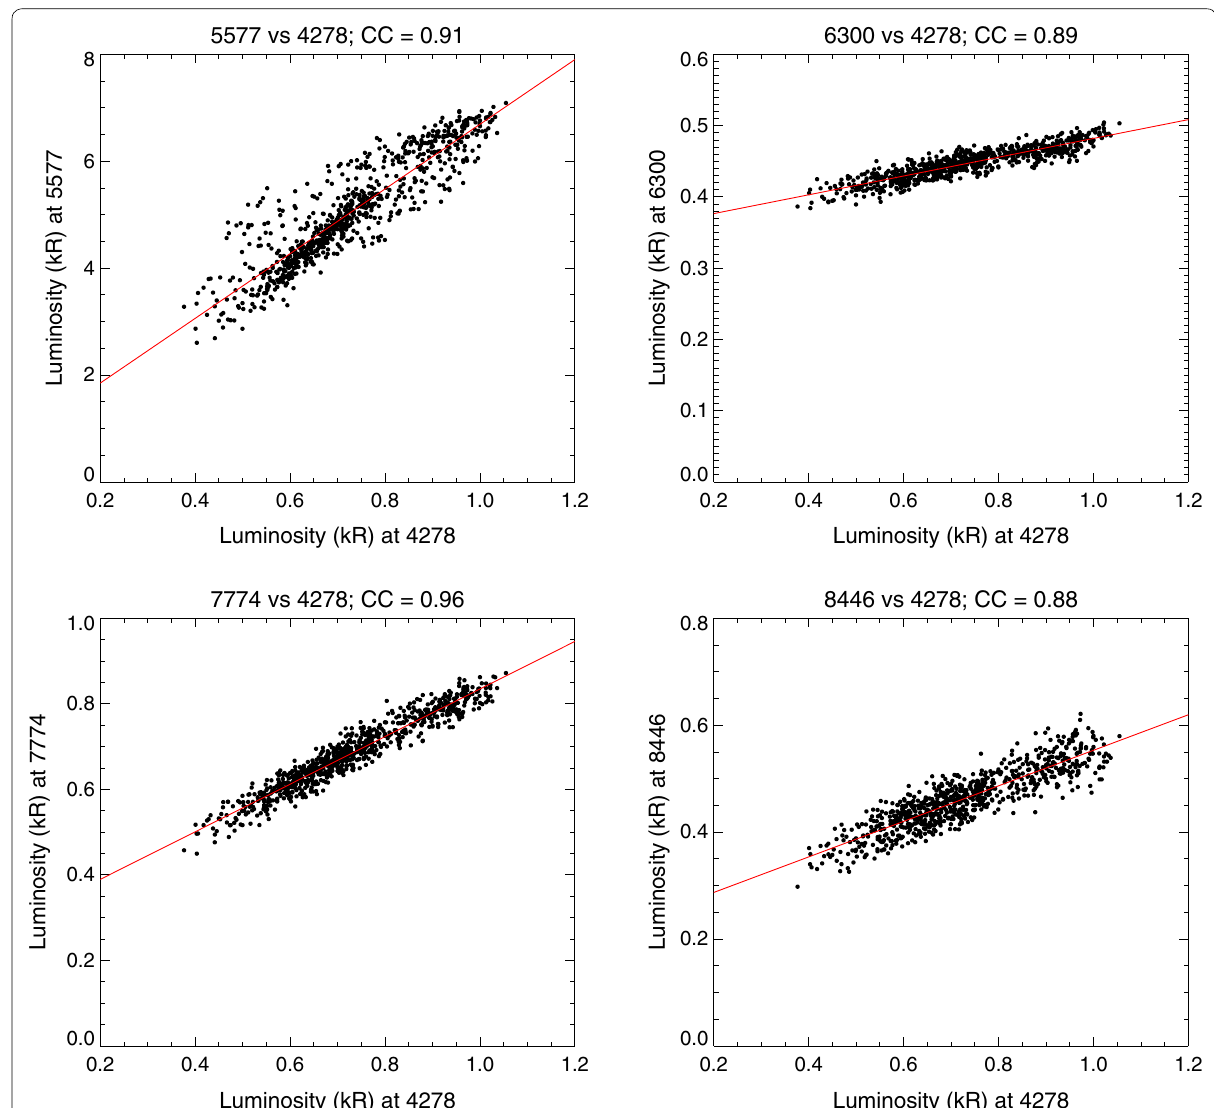
Fig. 20 Scatter plots of auroral intensities (1 s data) between 427.8 nm and 557.7 nm (top-left), 630 nm (top-right), 777.4 nm (bottom-left), and 844.6 nm (bottom-right) between 02:12:00 UT and 02:24:00 UT on January 23, 2018. Correlation coefficients (CC) are also shown at each